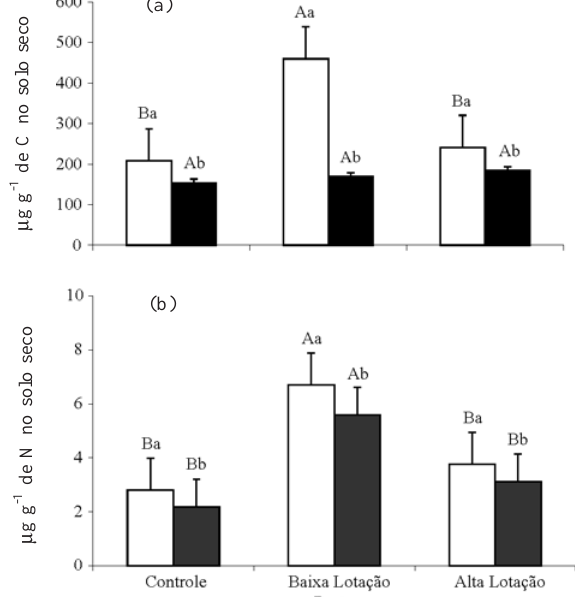
Figura 1. Carbono da biomassa microbiana (a) e nitrogênio da biomassa microbiana (b) encontrados nas camadas de 0–10 ( ) e 10–20 cm ( ) do solo pastejado por ovinos. Médias seguidas de mesma letra, minúscula (profundidade) e maiúscula (pastos), dentro de cada variável, não diferem entre si pelo teste de Tukey a 5 %. As barras representam o erro padrão (n = 15).